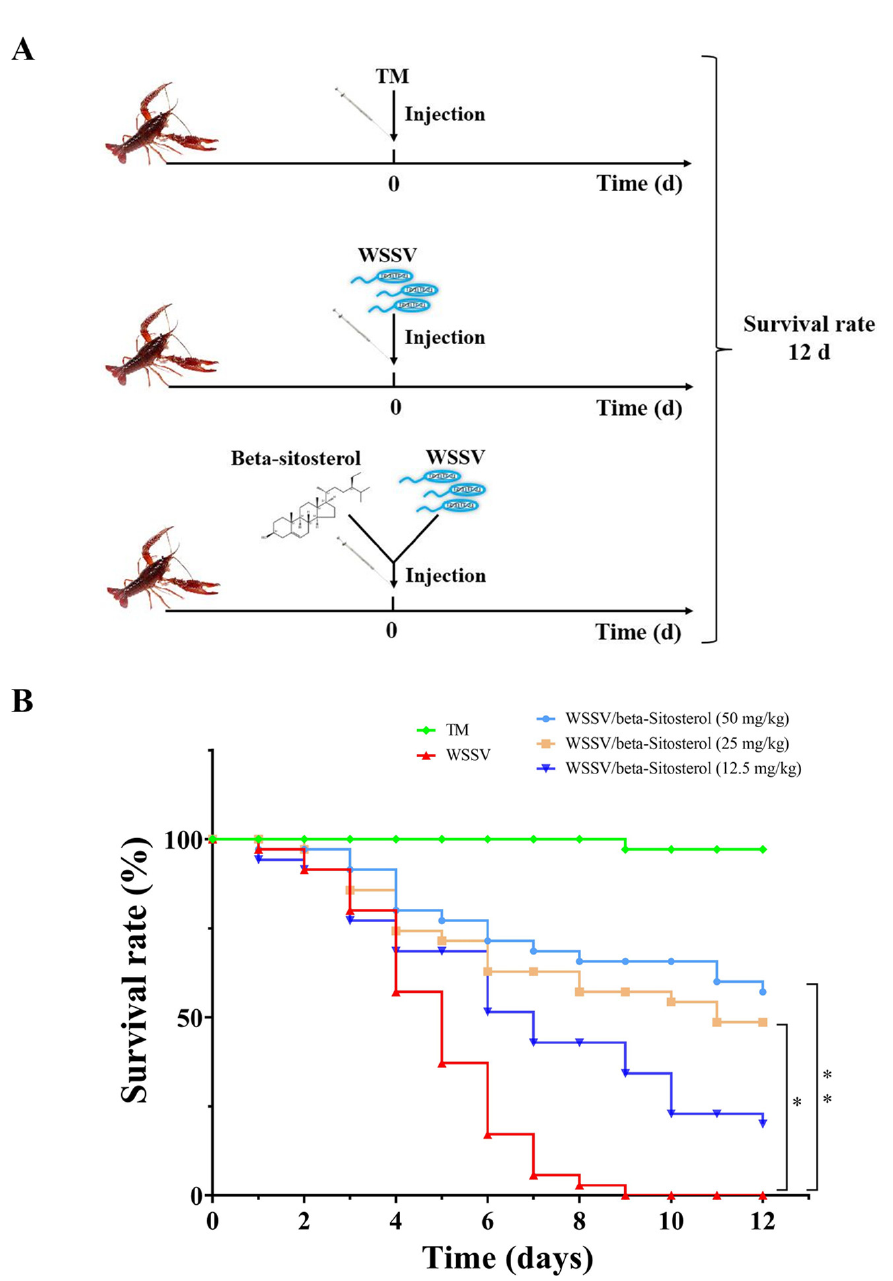
Figure 3. Beta-sitosterol increased the 12 day survival rate. ( A ) The experimental workflow. ( B ) The 12 day survivorship curves of crayfish in different groups. Asterisks indicate the significant difference between the experimental and control groups (* p < 0.05, ** p < 0.01).